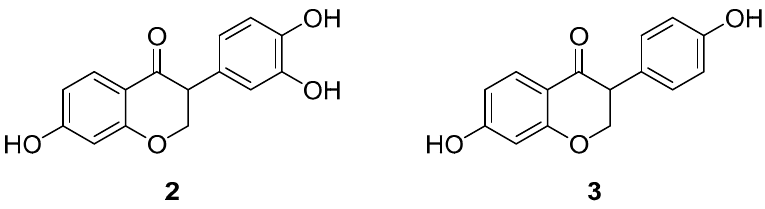
Figure 3. 7,3 ′ ,4 ′ -Trihydroxyisoflavone ( 2 ) and Daidzein ( 3 ).